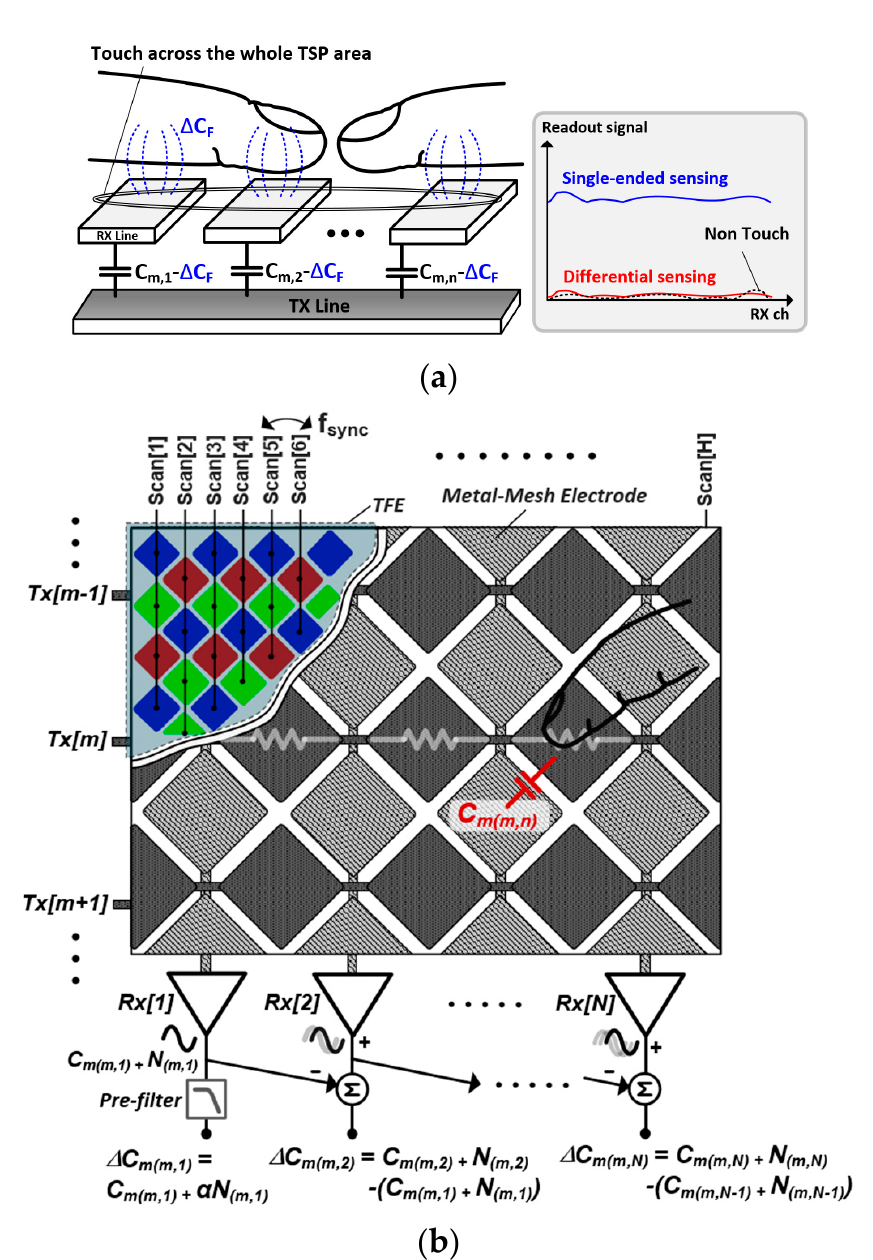
Figure 1. ( a ) Multi-touch user scenario showing missing touches of differential sensing and ( b ) conceptual diagram of proposed differential sensing scheme and stack-up structure of flexible AMOLED display.